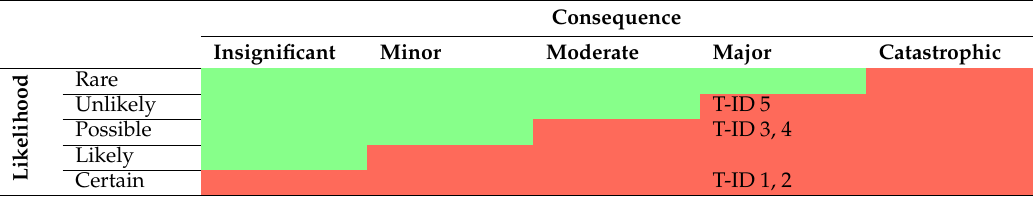
Table 15. Application of Risk Evaluation Matrix and threat IDs (T-ID) out of Step